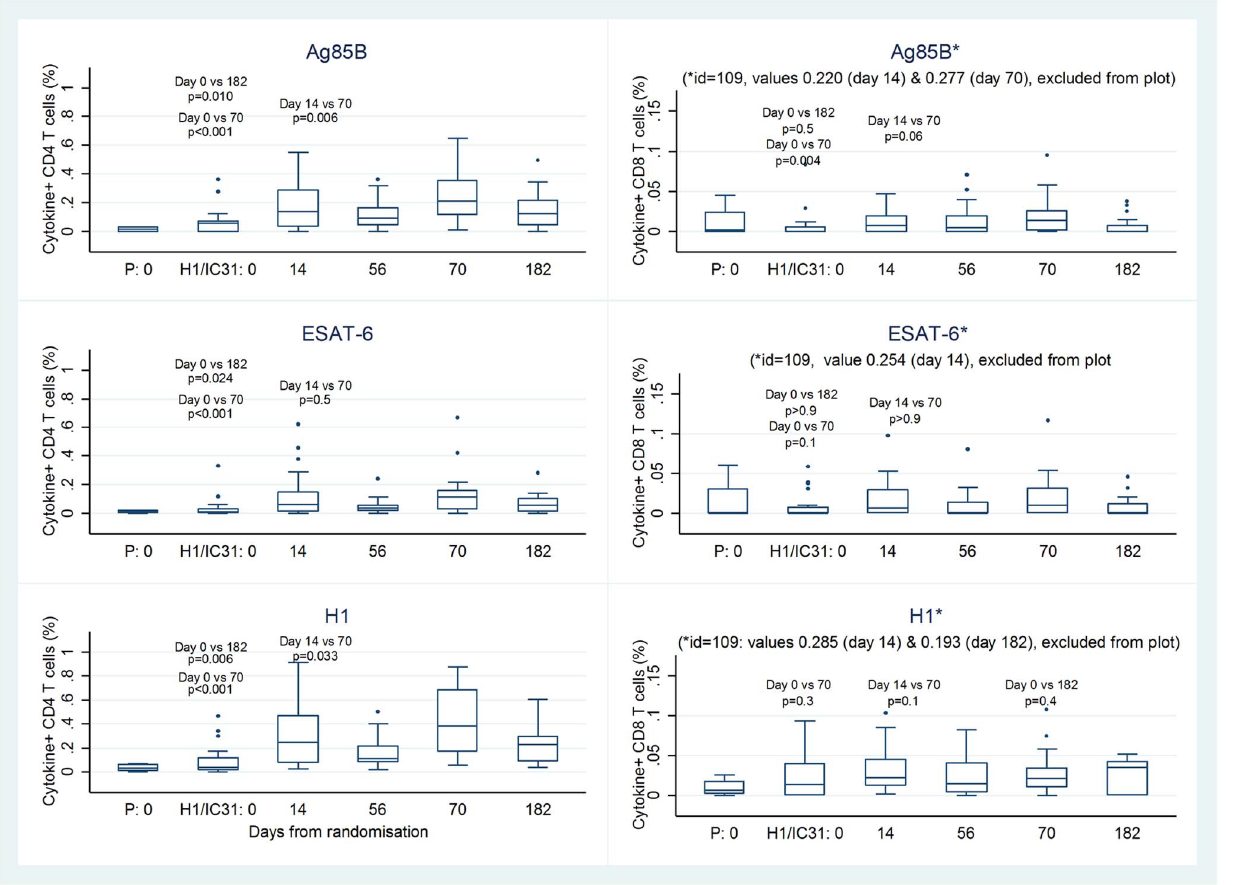
Fig. 3. Kinetics of Ag85B, ESAT-6 and H1 specific CD4 + and CD8 + T cells expressing IFN- c , TNF- a or IL-2 for day 0 for the placebo arm (P: day 0) and over a 6-month period (day 0–182) in the vaccine (H1/IC31) arm detected by a short-term whole blood intracellular cytokine